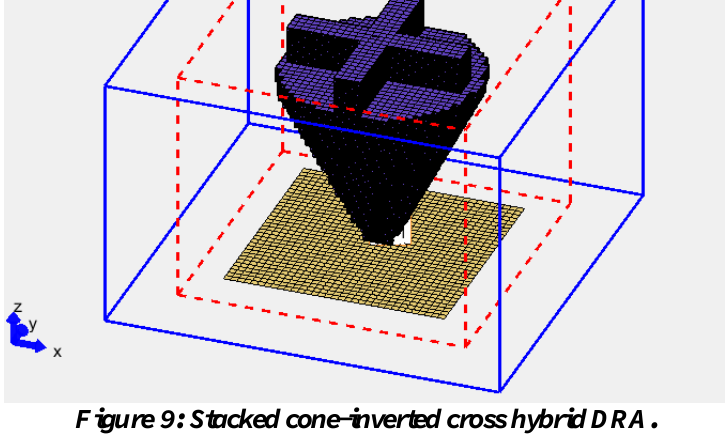
Figure 9: Stacked cone-inverted cross hybrid DRA.